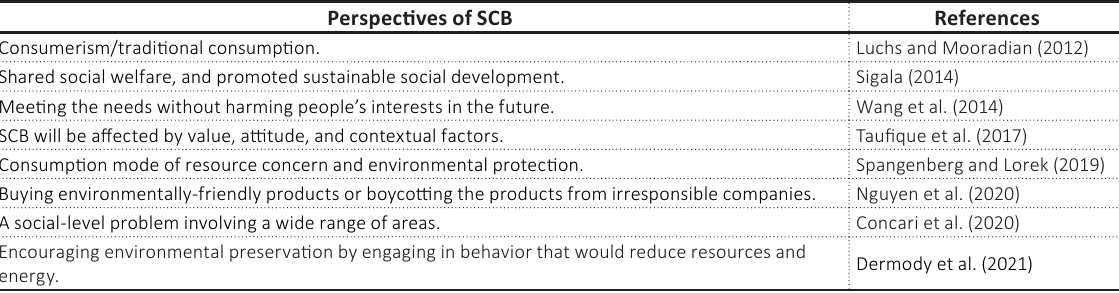
Table 2. Sustainable consumption behavior in different